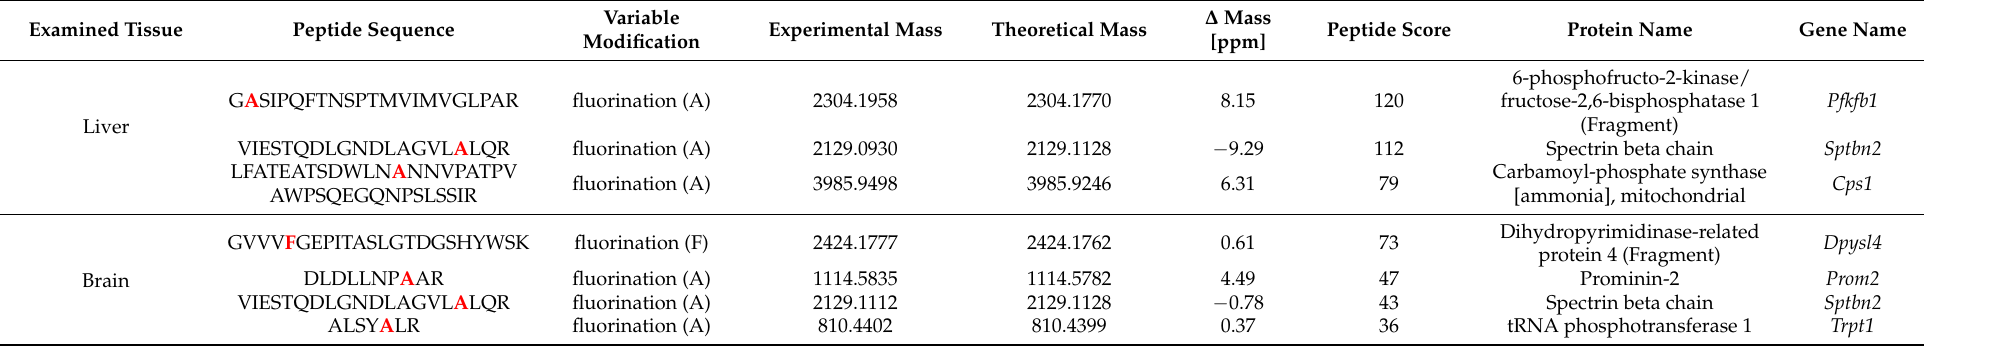
Table 1. List of confirmed identified fluorine-containing proteins based on automatic identification in the 21 day groups using Mascot software after manual